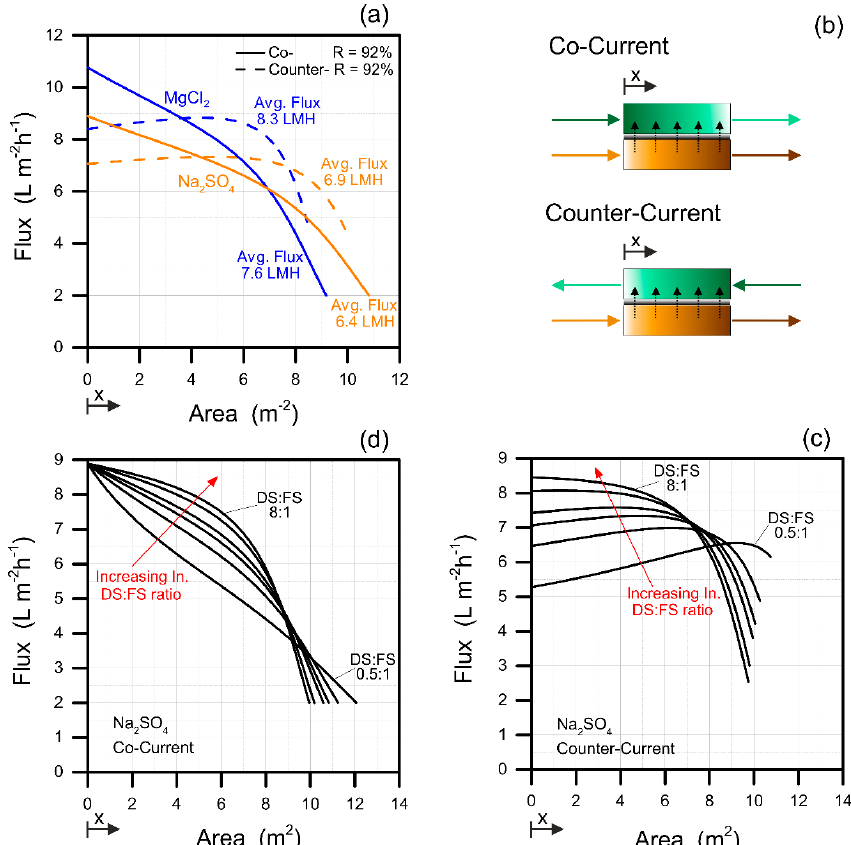
Figure 3. FO stage performance in co- vs. counter-current mode. ( a ) Water flux along the FO modules in the systems from Figure 2, for the (solid lines) cocurrent and (dashed lines) counter-current configurations. ( c , d ) Water fluxes along the modules at varying DS:FS ratios with influent π D equal to 15 bar. The two configurations are schematically depicted in ( b ).